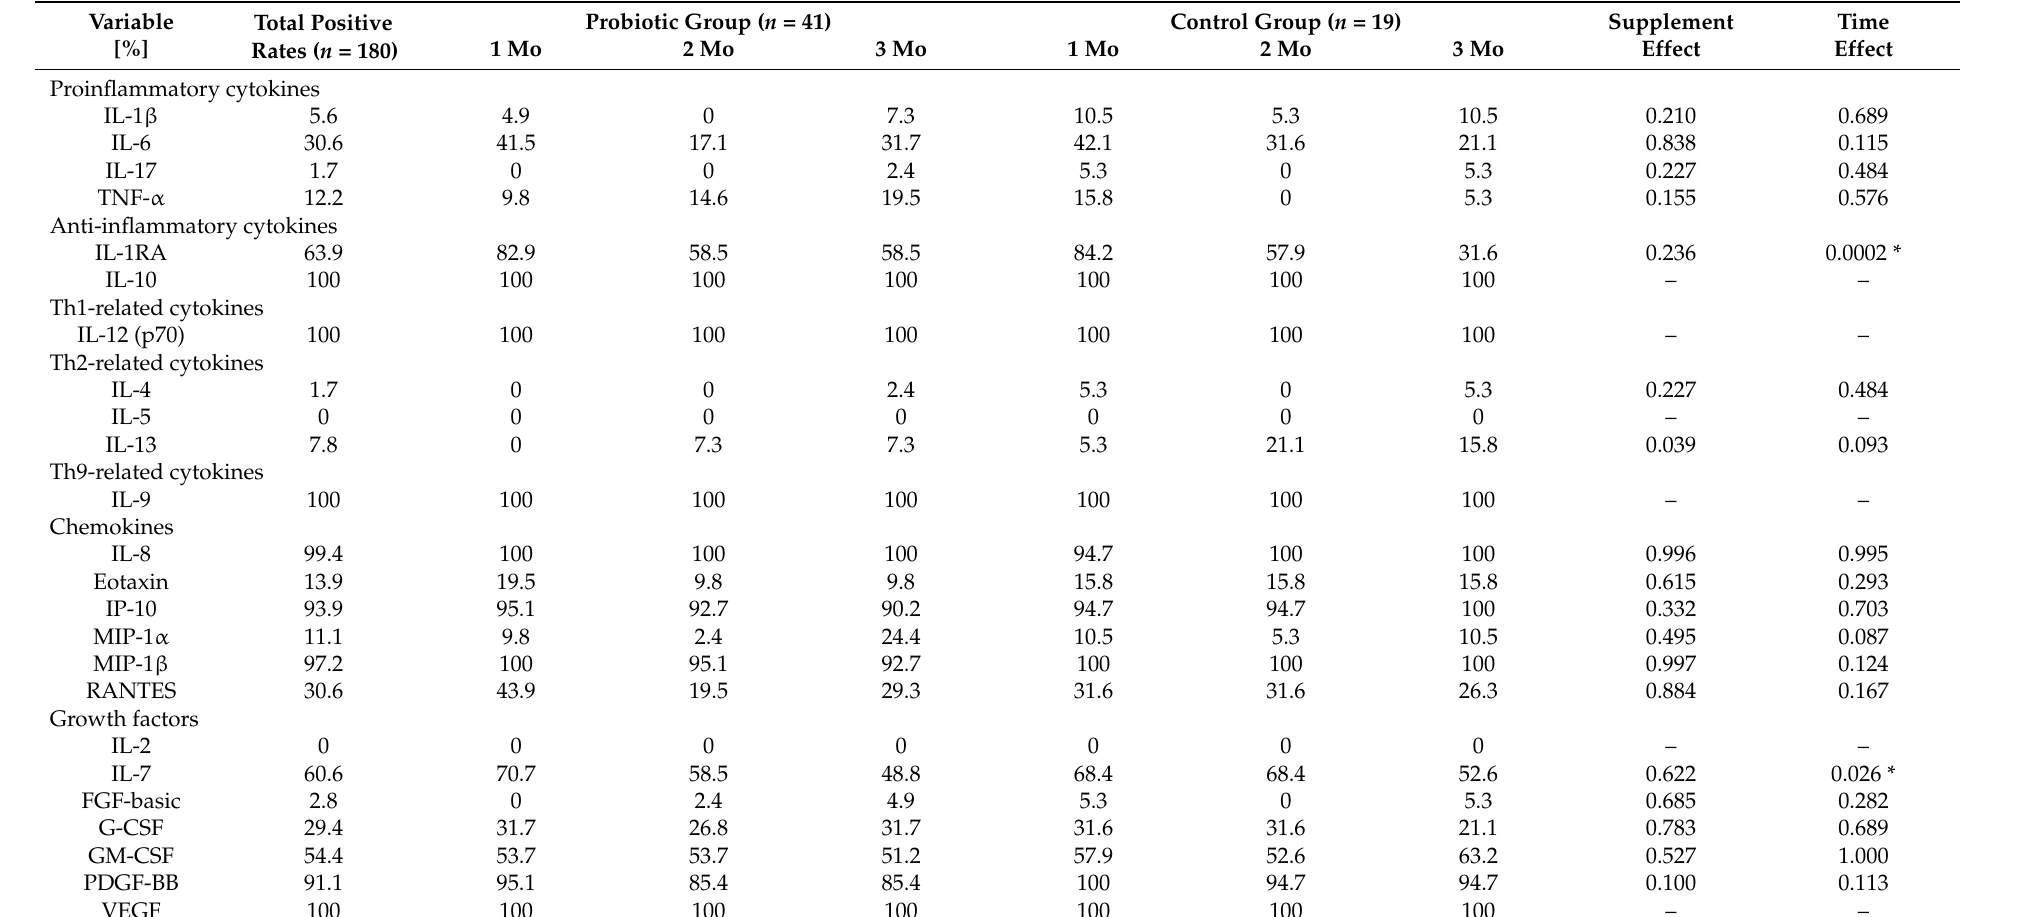
Table 3. Effects of probiotic supplementation on the positive rates of